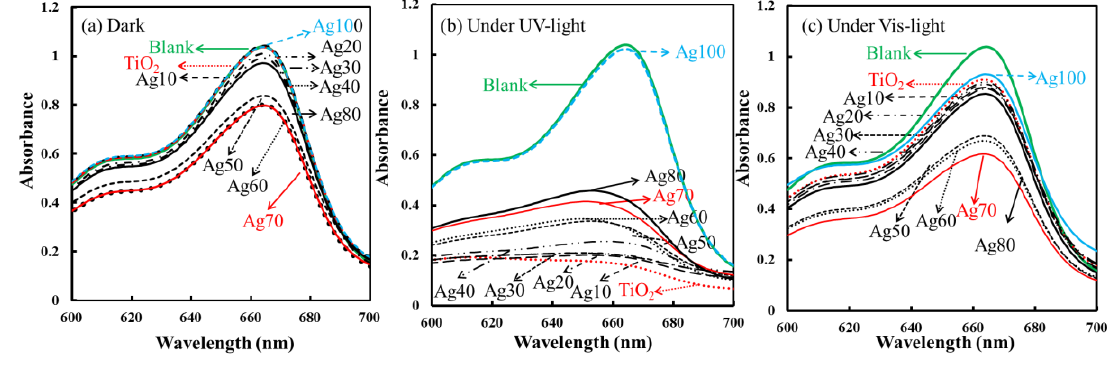
Figure 7. Absorption spectra of decomposition of 0.001 mmol of MB aqueous solution in the presence of different Ag-NP/TiO thin films after kept under ( a ) dark; ( b ) UV and 2 ( c ) vis-light irradiation for 18